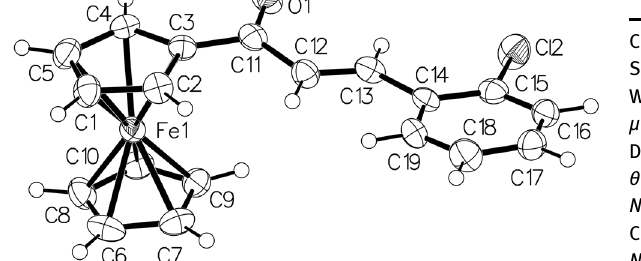
Table  : Data collection and